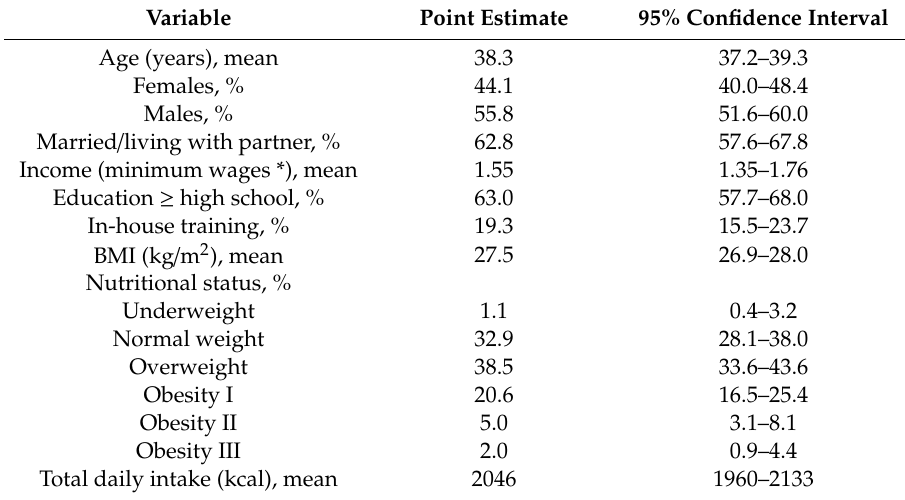
Table 1. Demographic characteristics of the population of manufacturing workers in the State of Rio Grande do Norte, Brazil, 2017–18.